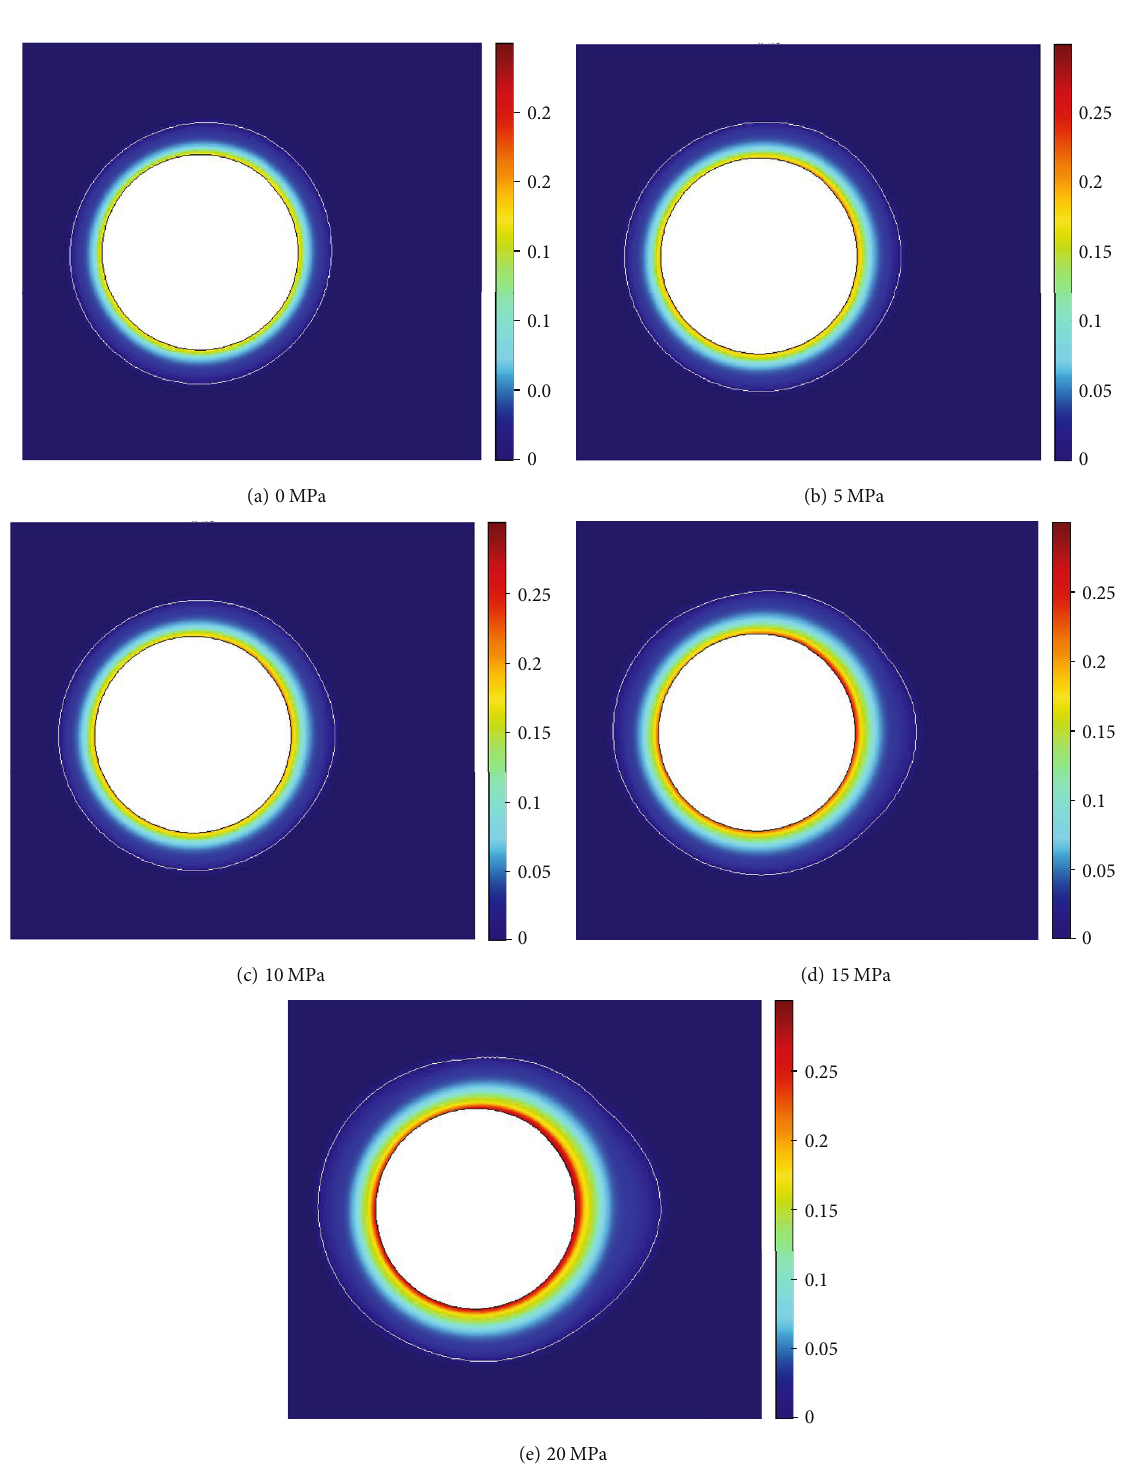
Figure 14: Damage distribution of surrounding rock after excavation under di ff erent water